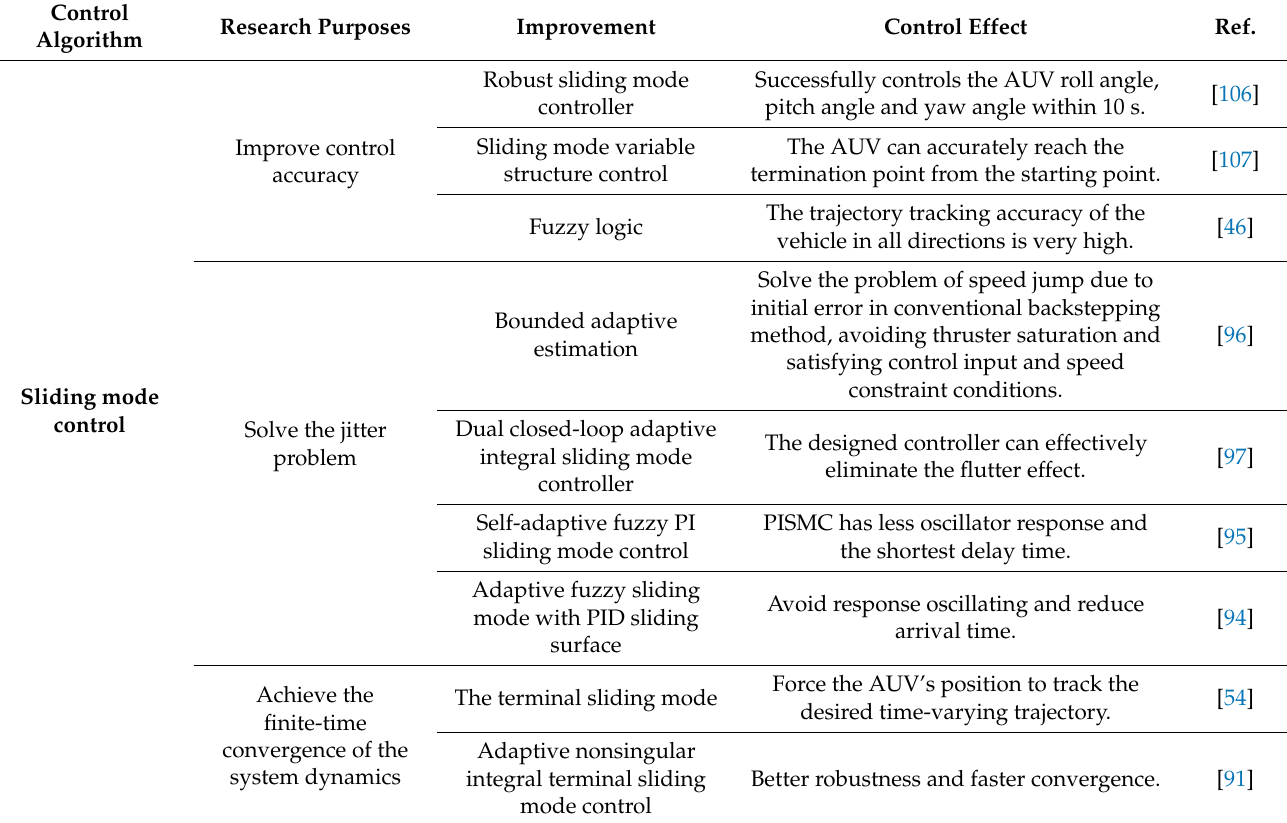
Table 4. Nonlinear time invariant control algorithm in AUV trajectory tracking. Control